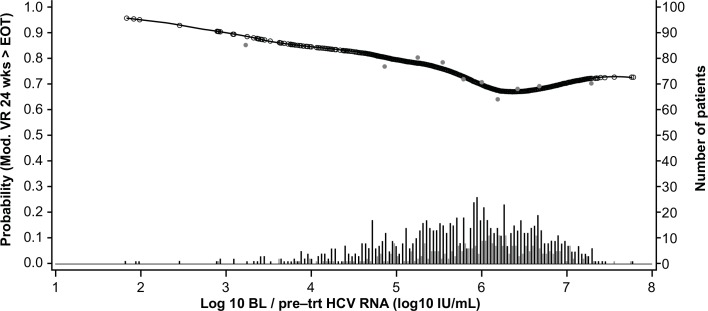
Relationship between serum hepatitis C virus RNA level and sustained virologic response (SVR).Short vertical lines indicate the number of patients with SVR (black lines) and no SVR (grey lines). Open circles represent probability of SVR according to the GAM analysis. Closed circles represent empirical probability for midpoints of deciles.